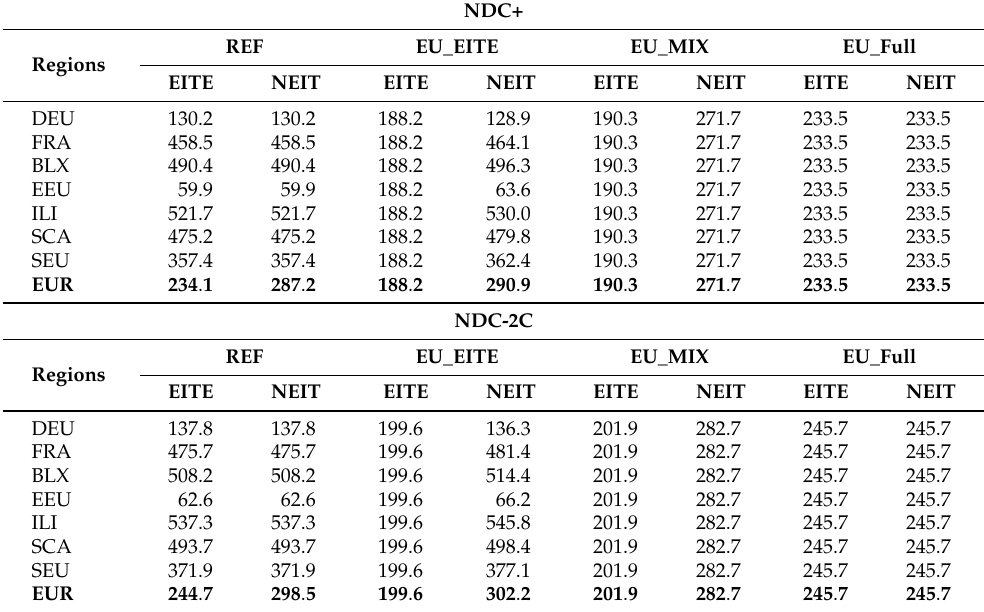
Table A1. CO 2 price ($/tCO 2 ) in the EITE and NEIT sectors for policy scenarios under the IEO baseline for the NDC+ and NDC-2C